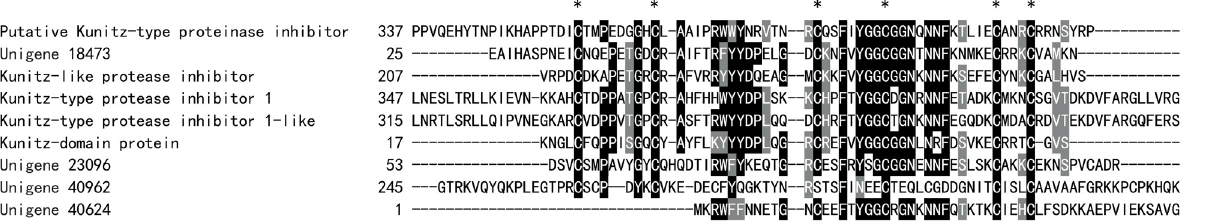
Fig 4. Alignment of the conserved sequence motifs of Kunitz-type inhibitors. The deduced amino acid sequences of unigenes 18473, 23096, 40962 and 40624 were aligned with known Kunitz-type inhibitors, including Ixodes scapularis Kunitz-domain protein (XP_002435213), Crassostrea gigas putative Kunitz-type proteinase inhibitor (EKC39386), Latrodectus hesperus Kunitz-like protease inhibitor (ADV40132), Astyanax mexicanus Kunitz-type protease inhibitor 1-like (XP_007252976) and Danio rerio Kunitz-type protease inhibitor 1 (AAI63937). The six highly conserved cysteine residues are indicated by